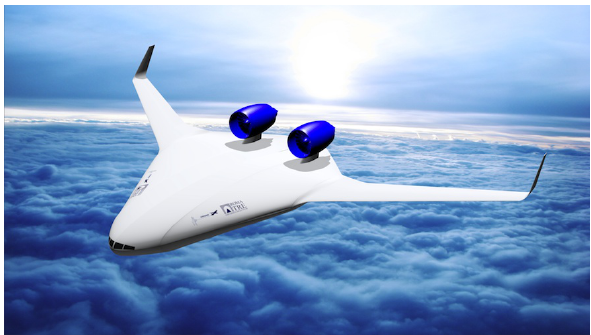
Figure 11: Pictorial rendering of the BWB concept developed during the OPENAIR